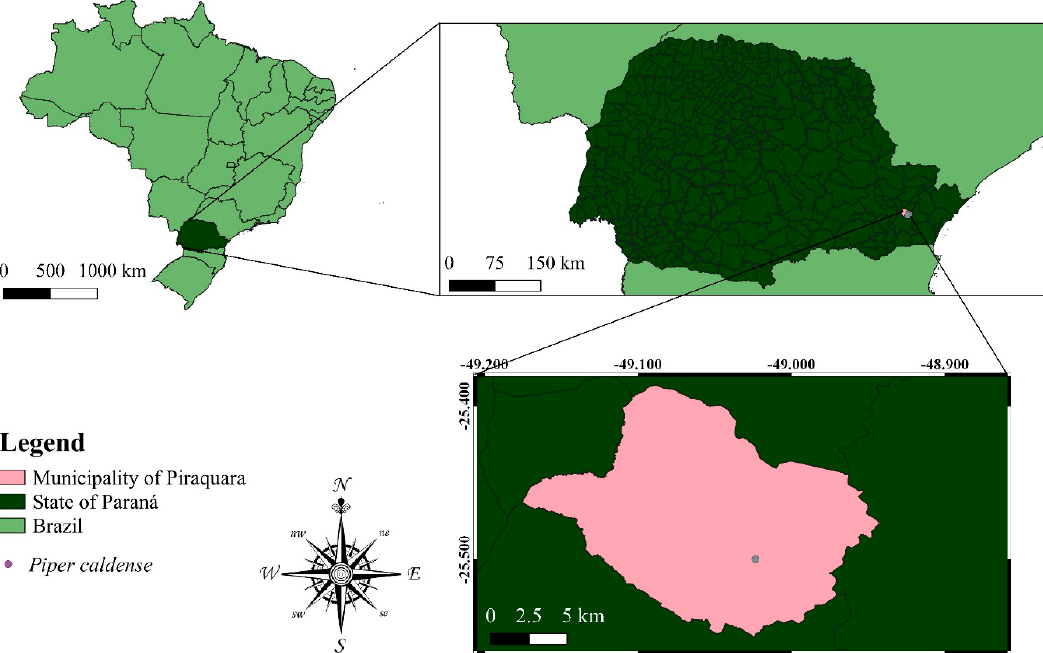
Figure 5. Location of the species Piper caldense in the municipality of Piraquara in the state of Paraná, Brazil.